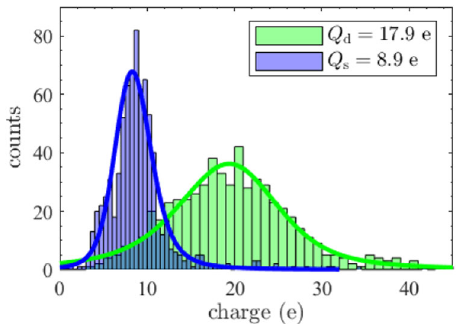
Fig. 3 Charge distribution single particles and two-particle clusters. Histograms of the measured charge distribution of singlets (blue) and doublets (green) together with their mean positive charge. The singlet and doublet distributions consist of 761 and 611 particles respectively, of which 4 singlets and 42 doublets have a charge outside the axis limits, within the range ( − 66 − 84)e. Although not plotted here, these data points are included in further analysis. The average singlet charge Q s and the average doublet charge Q d are indicated in the legend.